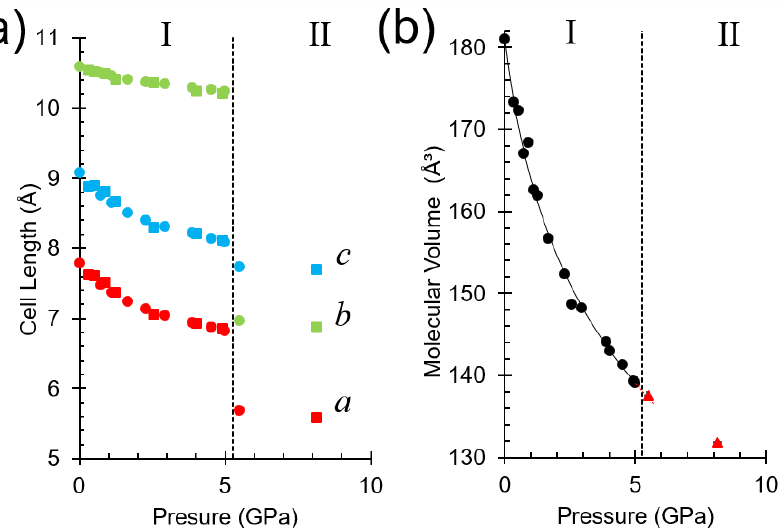
Figure 7. ( a ) Plot of unit cell parameters as a function of pressure. Ex situ crystal data are shown as circles and in situ crystal data are shown as squares. ( b ) Molecular volume of all phase I data, black circles, fitted to a 3rd order Birch-Murnaghan EOS and extrapolated to 5.7 GPa (red-dashed line). Phase II data are shown as red triangles. Error bars are obscured by data markers and the phase boundary is indicated by a dashed line in both figures.